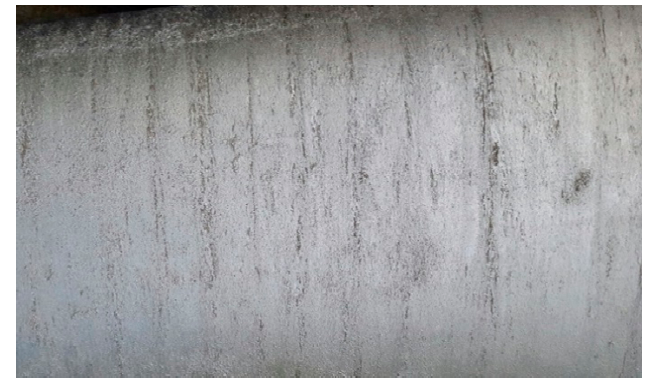
Figure 3. Sand side of cast sheet with grooves (1000 mm × 600 mm).